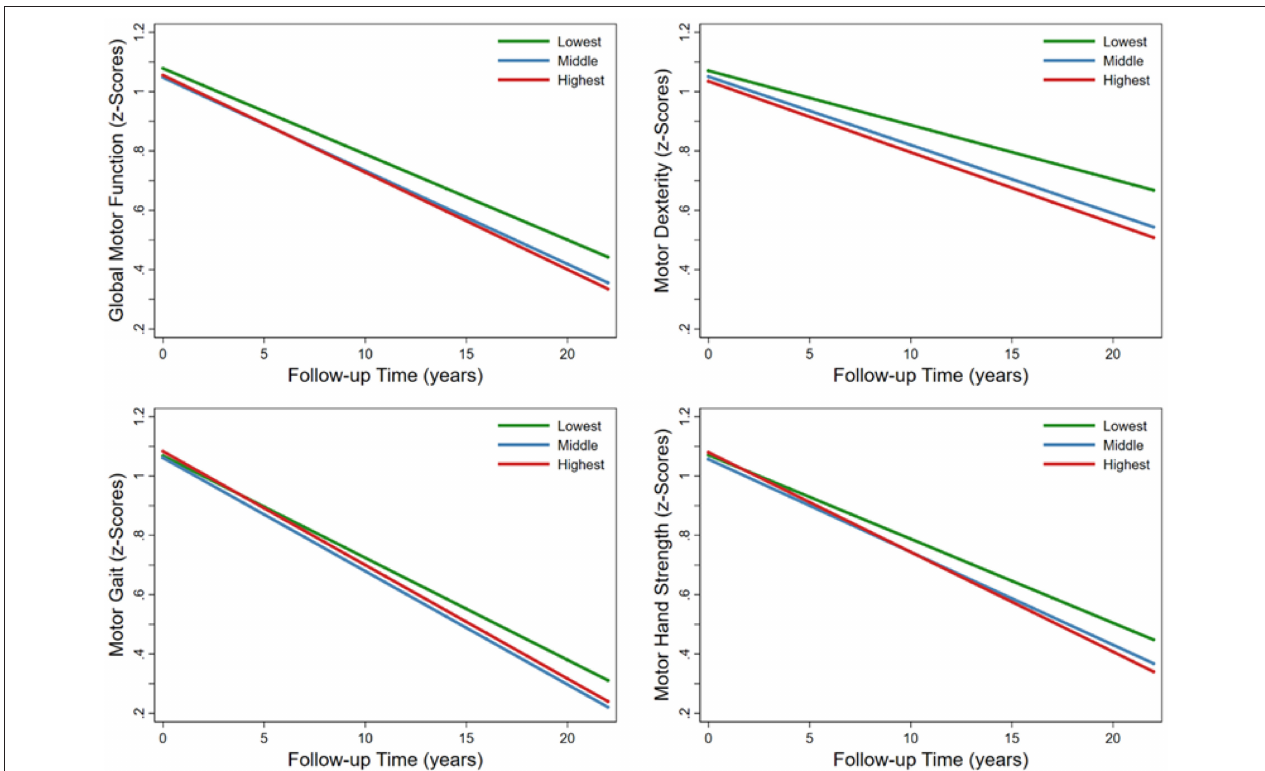
FIGURE 1 | Trajectories of average annual changes in global and specific motor functions by Framingham General Cardiovascular Risk Score (FGCRS) in tertiles. Model was adjusted for education, body mass index, alcohol consumption, physical activity, social activity, baseline number of cardiovascular diseases, and baseline global cognition score.